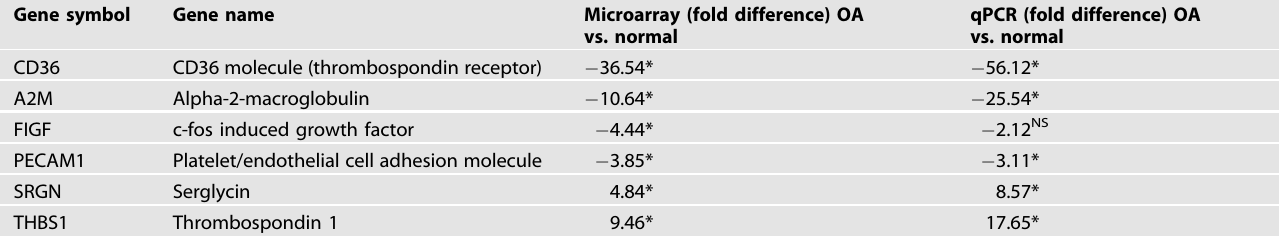
Table 1. Differentially regulated genes related in protein secretion in OA vs. normal synovial MPCs. Gene